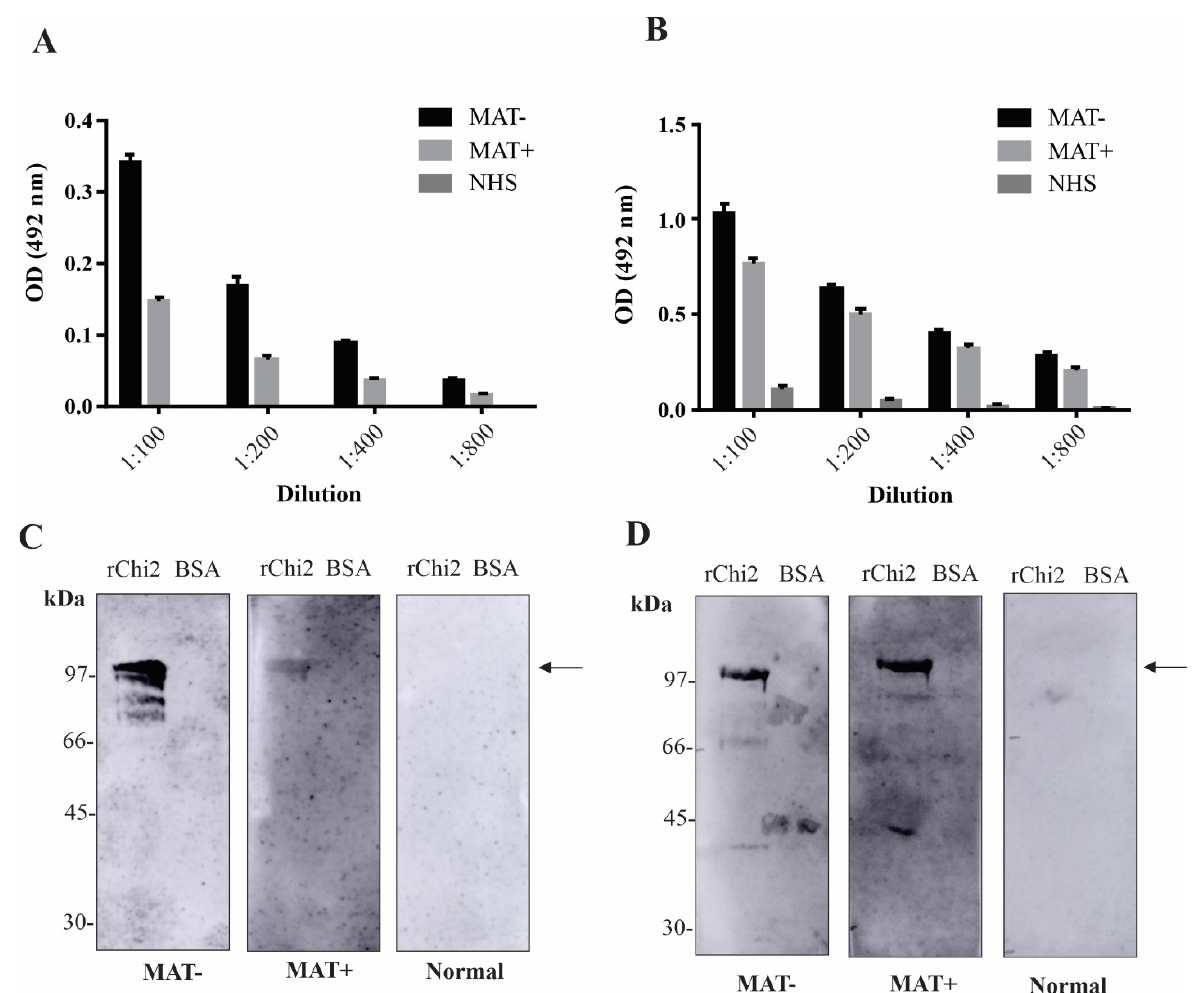
Figure 2. Pooled serum from patients at the onset (MAT − ) and in the convalescent phase (MAT+) and normal human serum (NHS) were incubated at different dilutions (1:100 to 1:800) with the immobilized rChi2 onto ELISA plates. Reactivity was detected either with HRP-conjugated anti- human IgM ( A ) or IgG ( B ). For assessing the specificity of antigen–antibody recognition, immunoblots were performed, and transferred rChi2 or BSA (negative control) were incubated with the polled samples at 1:1000 dilution. Reactivity was detected either with HRP-conjugated anti-human IgM ( C ) or IgG ( D